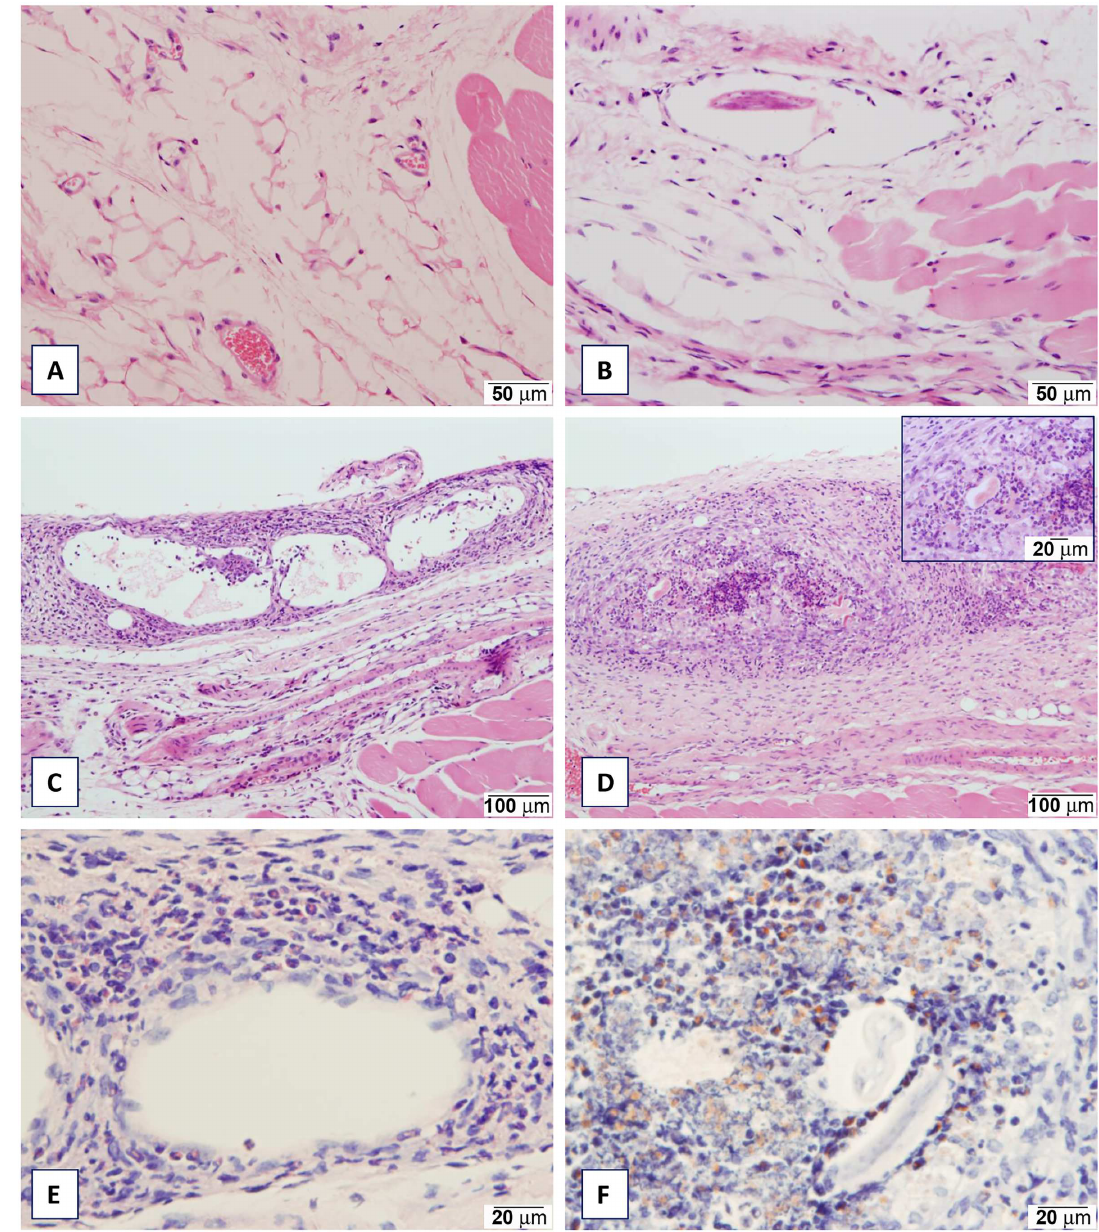
Fig 4. Histopathology of B . pahangi infected and uninfected limbs in a mouse model. BALB/c mice were injectedwith 50 L3 of B . pahangi into the RHS footpad and with HBSS into the LHS footpad and analysedon the days p.i. as indicated. (A) uninfectedmouse, Day 21, HBSS-injected limb: there is no inflammation in the fascial plane (B) infected mouse, Day 7: a filarial nematodeis present within the lumen of a dilated lymphaticvessel in the fascial plane. (C) infected mouse, Day 14 prominent lymphangiectasis and lymphangitis in the fascial plane. (D) infected mouse, Day 21: marked inflammatory infiltration obliteratingthe lumen of a lymphaticvessel. Inset: remnants of degeneratenematodes within the lumen surroundedby inflammatory cells. (E) infected mouse (same animalas section C), Day 14: the inflammatory infiltrate affecting the lymphatic vessel in the fascial plane is characterised by the presenceof many eosinophils highlightedby the modified haematoxylin eosin method. (F) infected mouse, Day 21: nematodes surroundedby intenseinflammatory infiltrationcomprising large numbers of eosinophils highlightedby the modified CongoRed protocol.